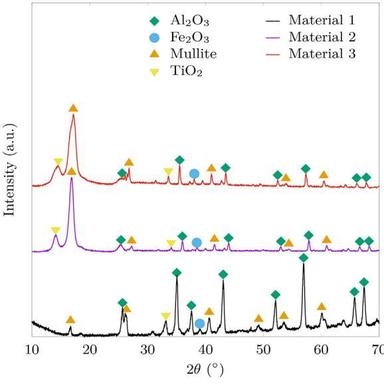
XRD patterns of materials 1–3.